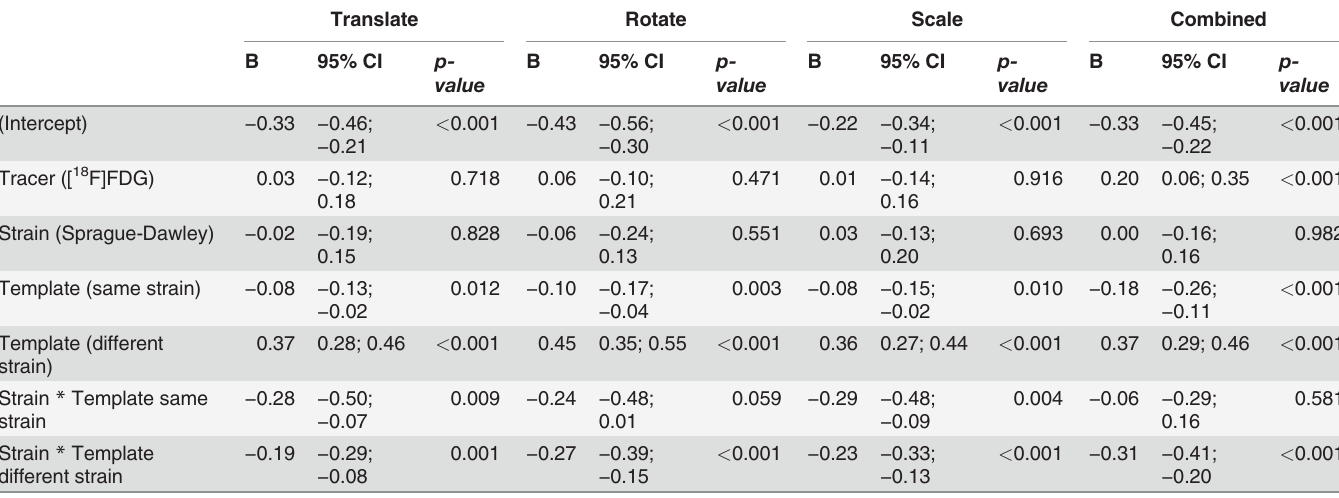
Table 5. Registration errors: effect of strain specific